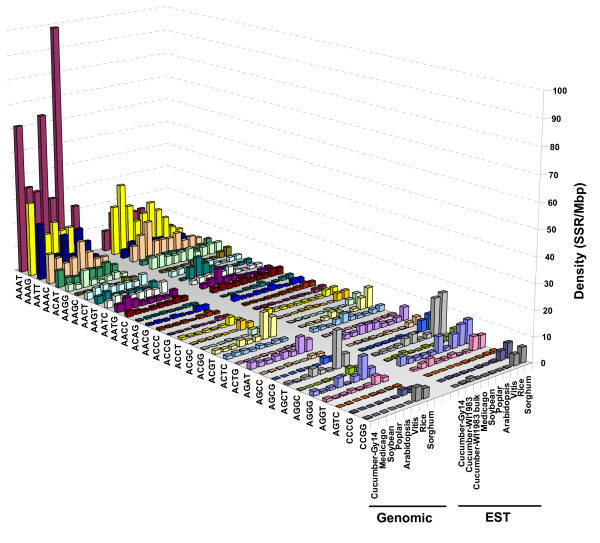
Distribution of tetranucleotide repeats in genomic and EST sequences of cucumber and seven other plant species. Frequency values are expressed as number of repeats per million base pairs of sequence. Species are arranged in order to their phylogenetic relationship with cucumber. All species considered, repeats of AAAT (T = 3.46, P = 0.009), AATT (T = 3.90, P = 0.005), AAAC (T = 2.71, P = 0.017), ACAT (T = 3.07, P = 0.008), AACT (T = 4.04, P = 0.001), AATC (T = 3.67, P = 0.003), and AATG (T = 2.25, P = 0.041) were significantly more frequent in genomic- than in EST sequences, whereas the AACC (T = 2.39, P = 0.031) tetranucleotides were more abundant in EST data. Refer to Additional file 1 (supplement Tables S2a and S3a) for details on frequencies of individual tetranucleotide motifs.